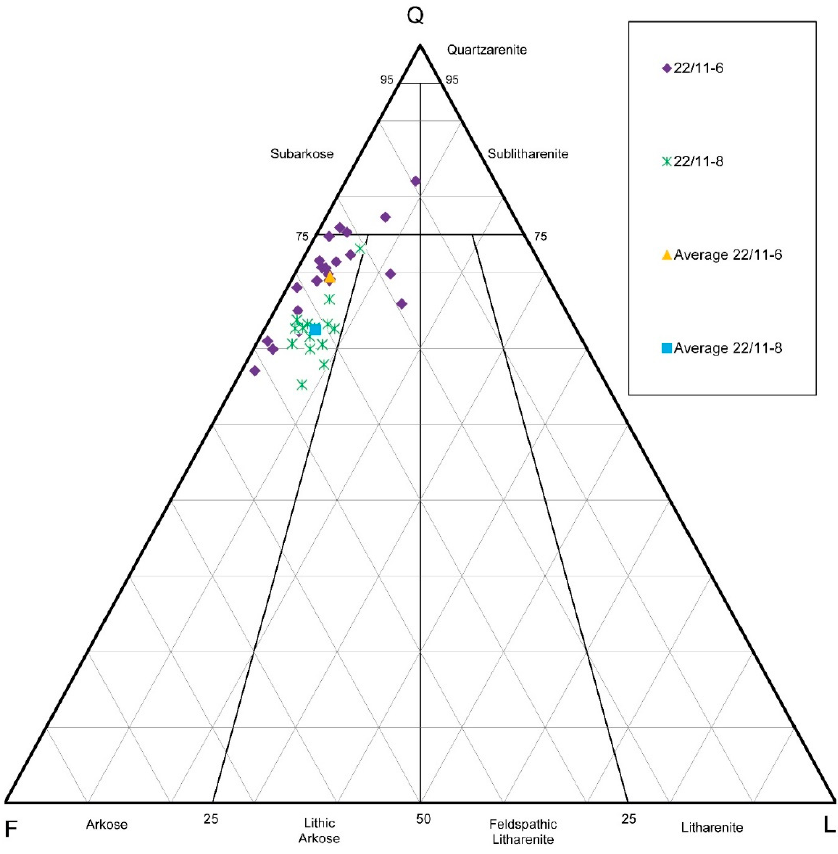
Minerals 2022 , 12 , x FOR PEER REVIEW Figure 3. Modal composition for the Forties Sandstone Member, after [55,56]. Figure 3. Modal composition for the Forties Sandstone Member, after [55,56].